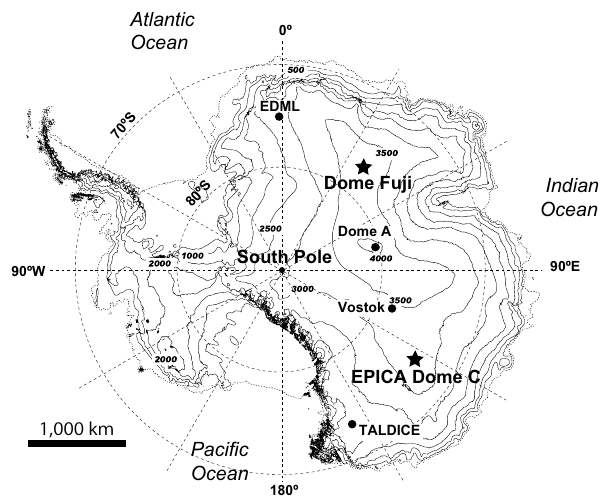
Figure 1. Map of the continent of Antarctica with elevation con- tours every 500m. The two ice coring sites used in this study, Dome C and Dome Fuji, are marked with